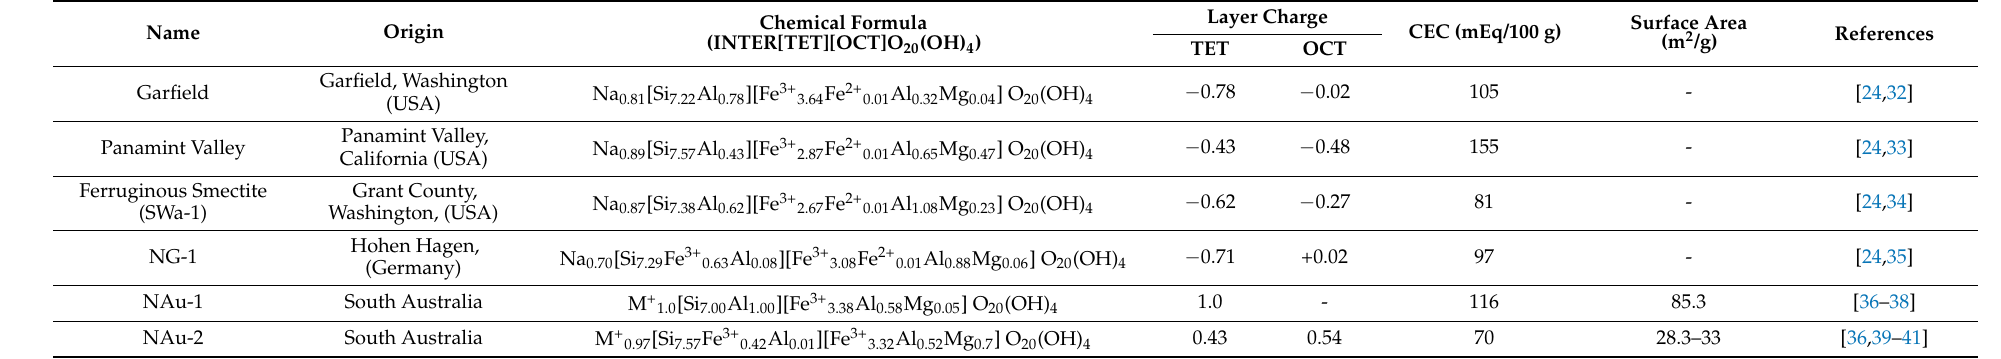
Table 1. Characteristics of nontronite clay